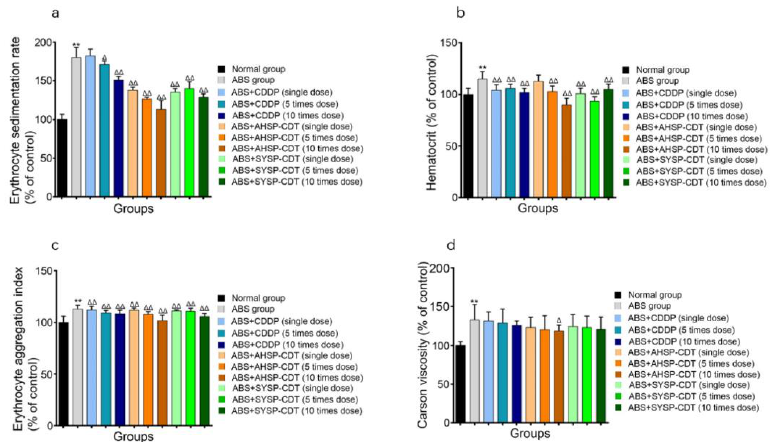
Figure 12. Bar chart of Danshen preparations’ effect on the erythrocyte sedimentation rate (ESR) ( a ), hematocrit (HCT) ( b ), erythrocyte aggregation index (EAI) ( c ) and Carson viscosity ( d ) of acute blood stasis rats. Compared with the normal group, * p < 0.05, ** p < 0.01; Compared with the ABS group, Δ p < 0.05, ΔΔ p < 0.01.